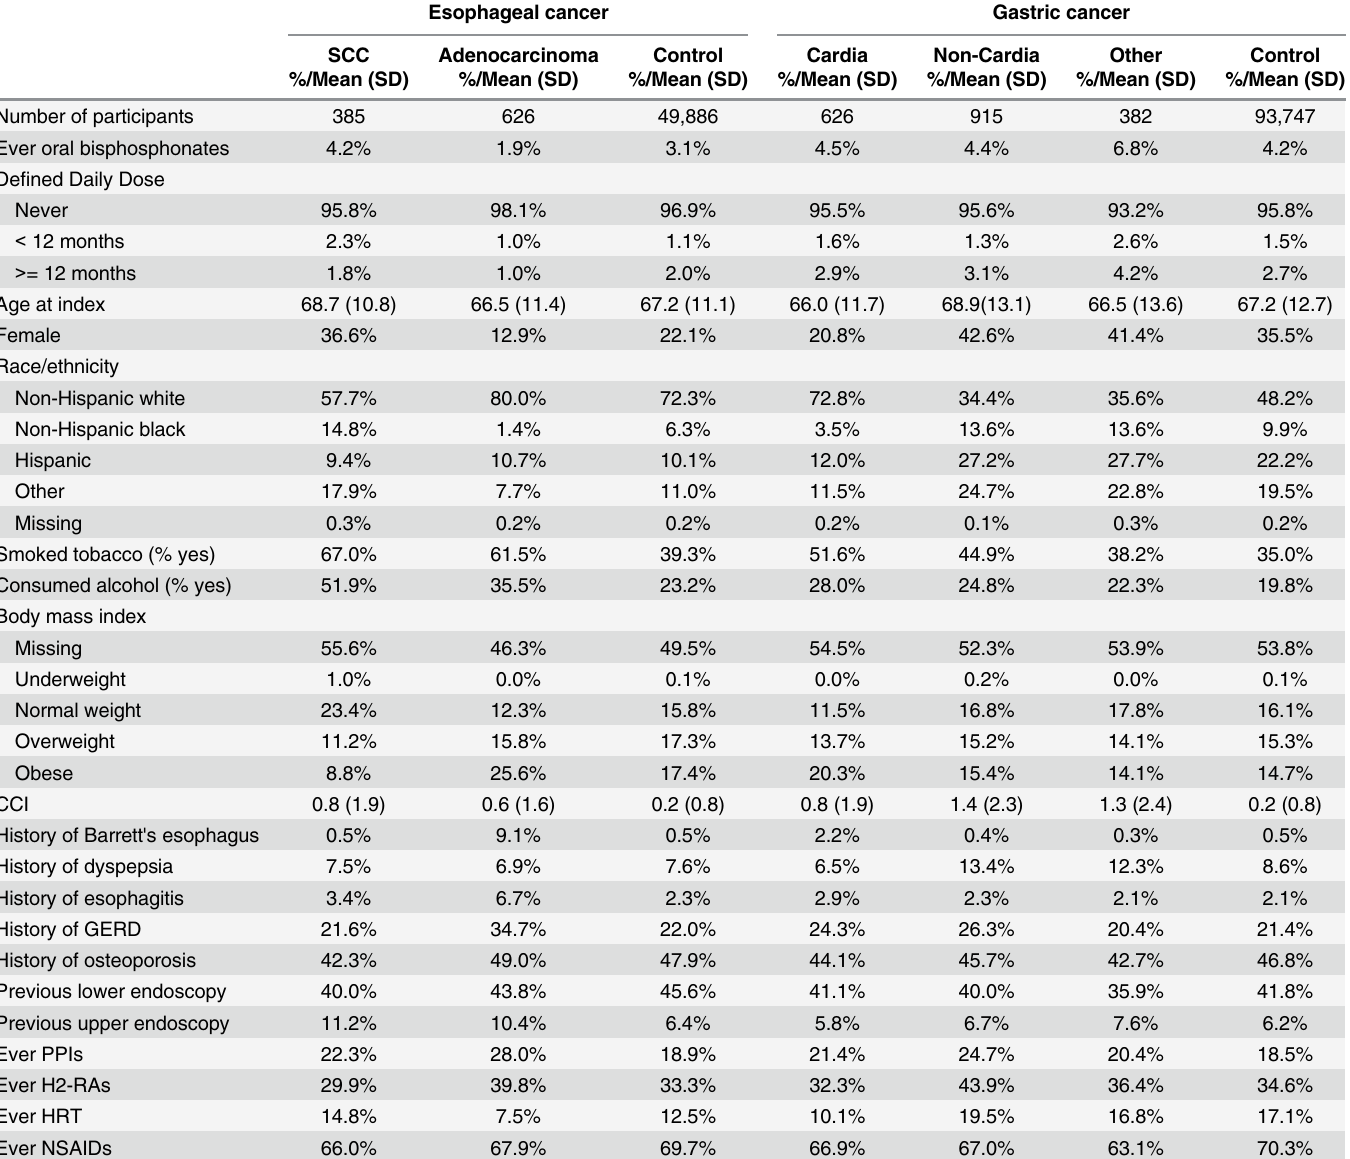
Table 1. Descriptive characteristics of the esophageal and gastric cancer cases and controls from Kaiser Permanente, Northern California, 1997 –